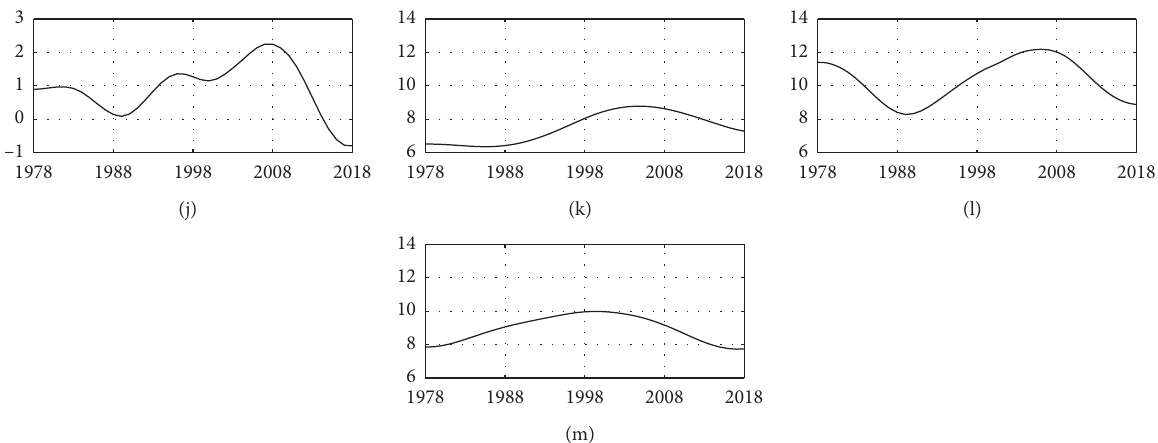
Figure 2: Economic fluctuation components and trend items of various provinces (a). IMF1 of Heilongjiang (b). IMF1 of Jilin (c). IMF1 of Liaoning (d). IMF2 of Heilongjiang (e). IMF2 of Jilin (f). IMF2 of Liaoning (g). IMF3 of Heilongjiang (h). IMF3 of Jilin (i). IMF3 of Liaoning (j). IMF4 of Heilongjiang (k). RES of Heilongjiang (l). RES of Jilin (m). RES of